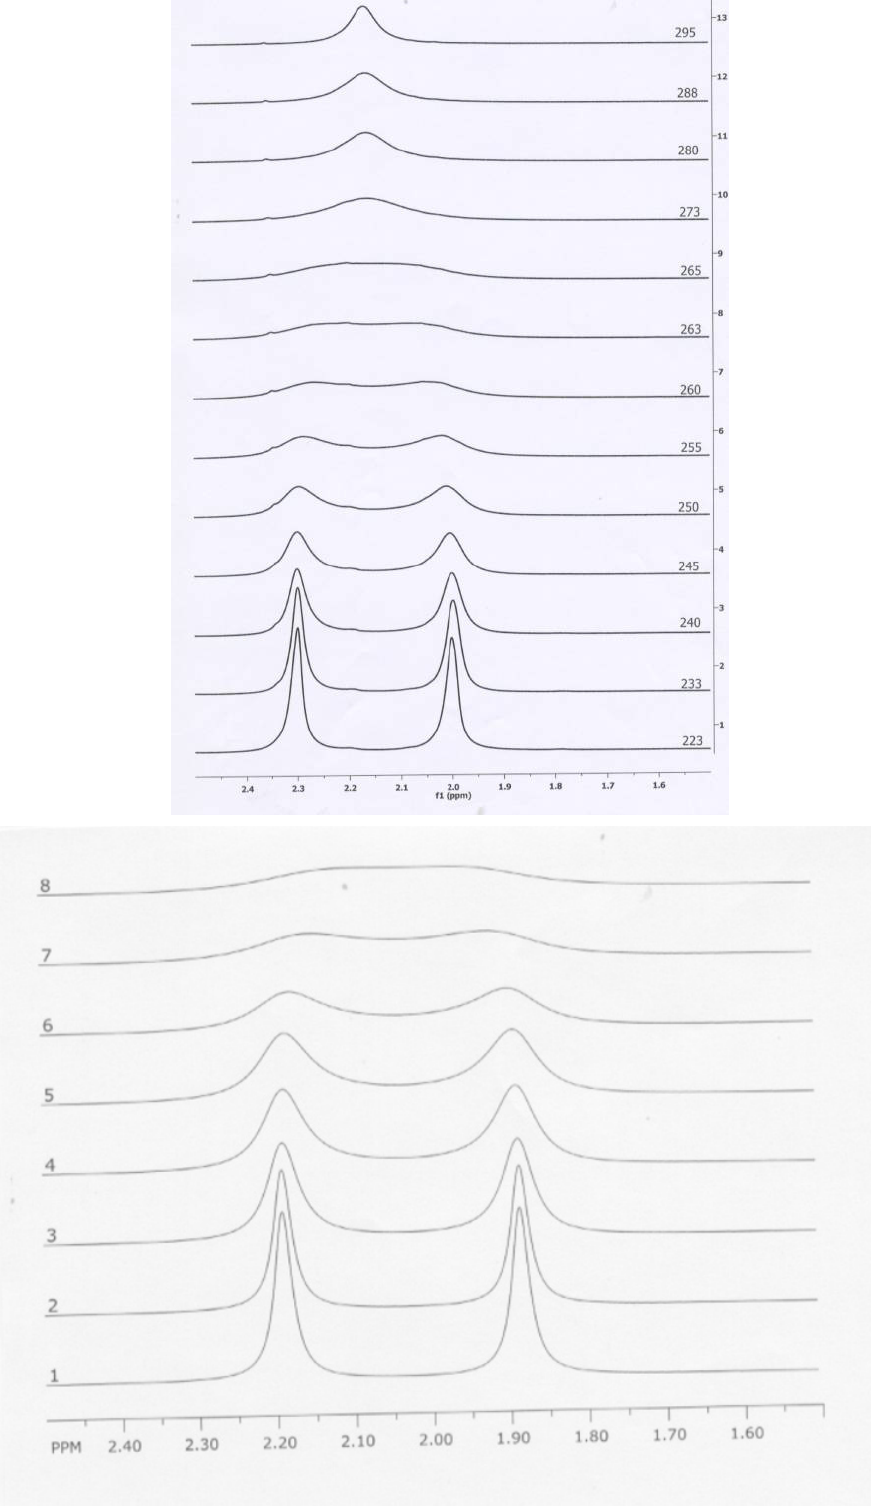
Figure 8. 1 H spectrum of 15 with 2.5 moles of water added; (a) experimental traces, (b) simulated traces for temperatures from 223 K to 263